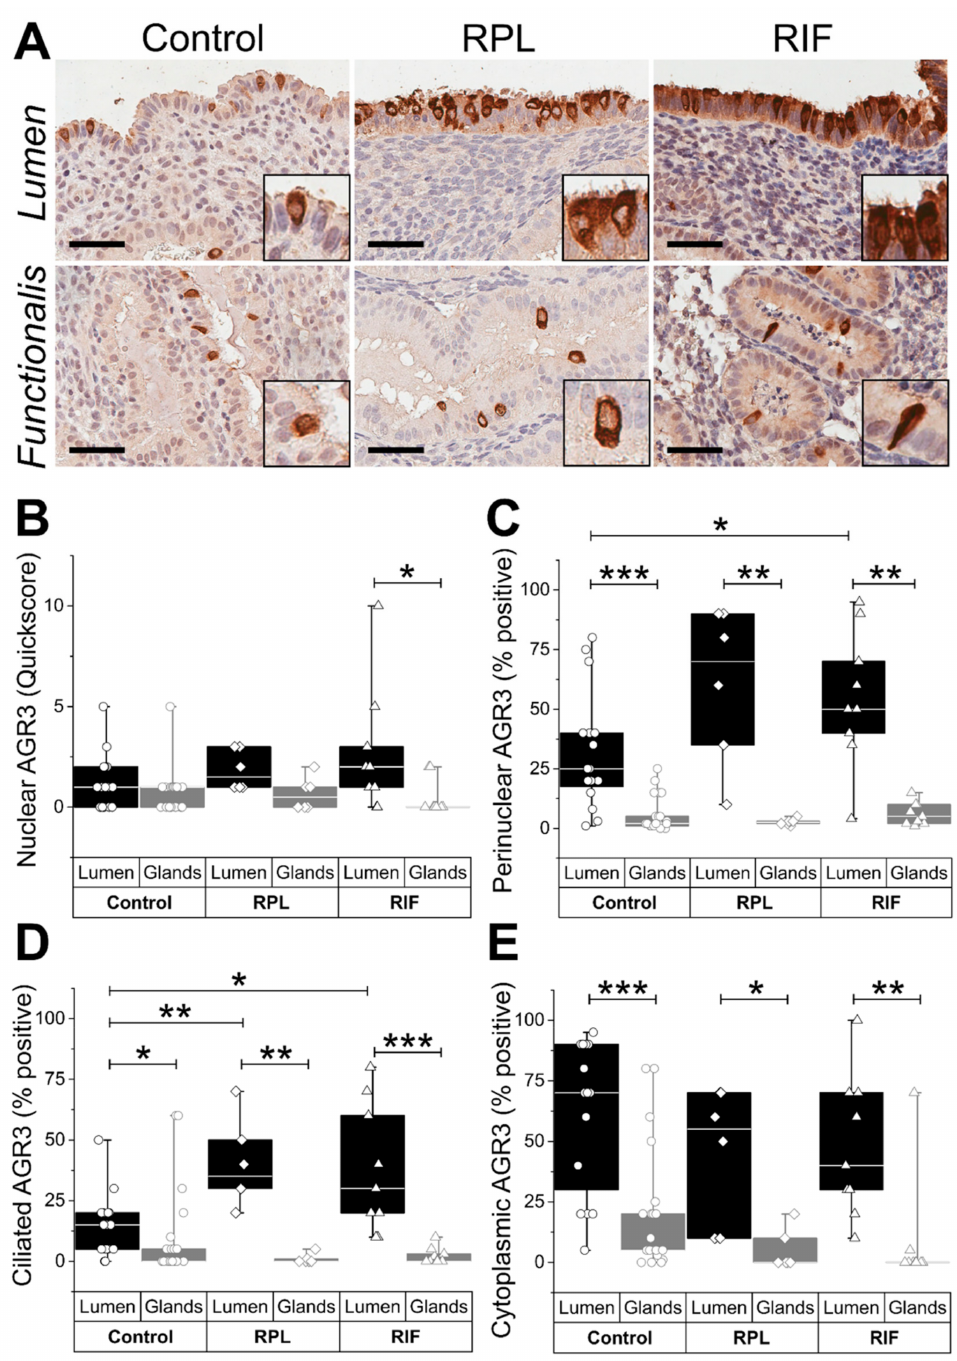
Figure 2. Endometrial AGR3 expression in control and recurrent reproductive failure. ( A ) Represen- tative micrographs demonstrate AGR3 immunostaining in endometrial tissue from fertile (control), recurrent pregnancy loss (RPL), and recurrent implantation failure (RIF) patients. Scale bar 50 µ m. Immunostaining scores for ( B ) nuclear, ( C ) perinuclear, ( D ) ciliated, and ( E ) cytoplasmic AGR3 expression in the luminal and glandular epithelium. * p < 0.05, ** p < 0.01, and *** p <